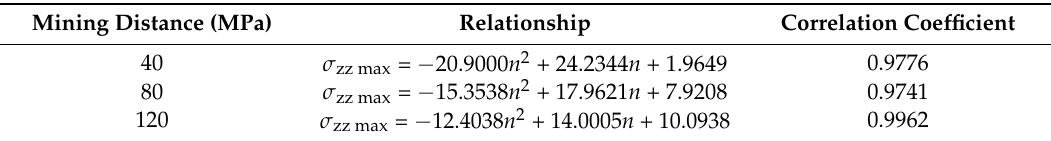
Figure 20. Coupling effect of the cemented rockfill’s granule gradation and mining distance on the maximum stress of the rock mass in the coalface. Table 9. Relationship between the maximum internal stress of the backfill and Talbot index of the cemented rockfill at different mining distances.